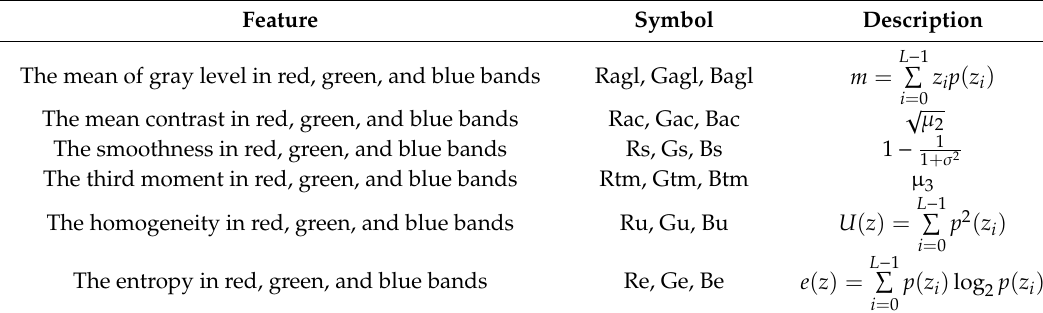
Table 3. The extracted texture features for each seed. Feature Symbol Description The mean of gray level in red, green, and blue bands Ragl, Gagl, Bagl The mean contrast in red, green, and blue bands The smoothness in red, green, and blue bands The third moment in red, green, and blue bands The homogeneity in red, green, and blue bands The entropy in red, green, and blue bands Re, Ge,